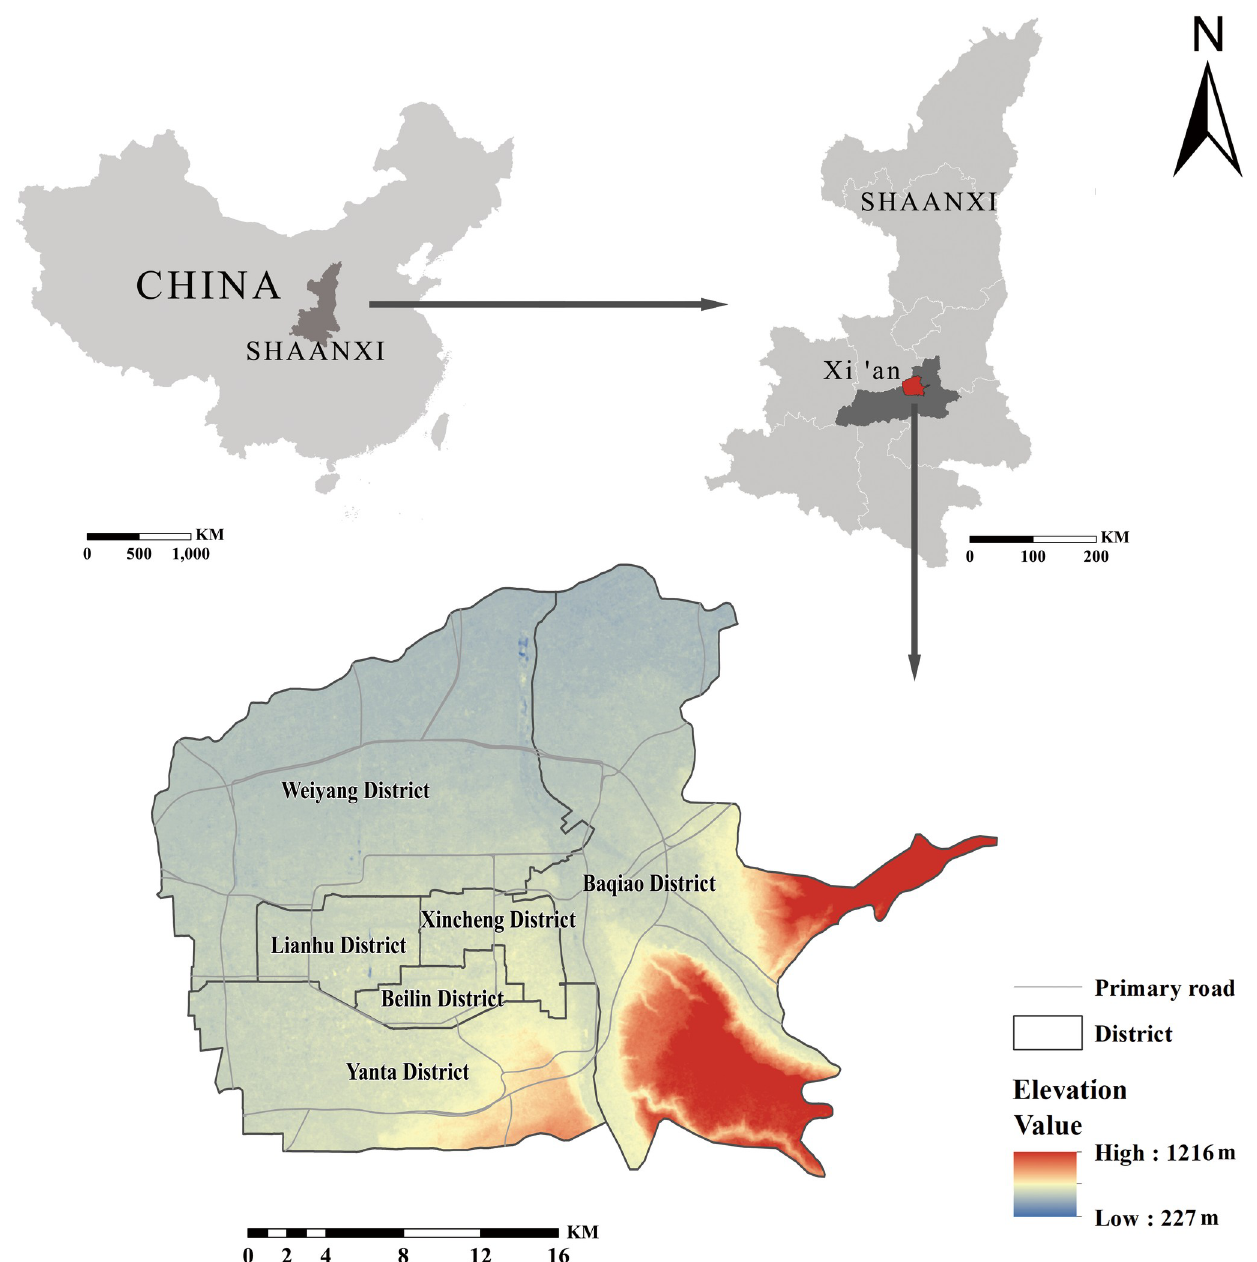
Fig 1. Location of study area. The map images are from the National Catalogue service for Geographic Information: http://www.ngcc.cn/.